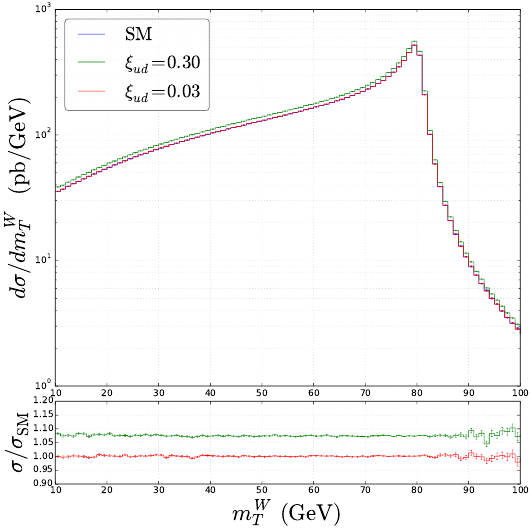
p S = 13 TeV in the presence